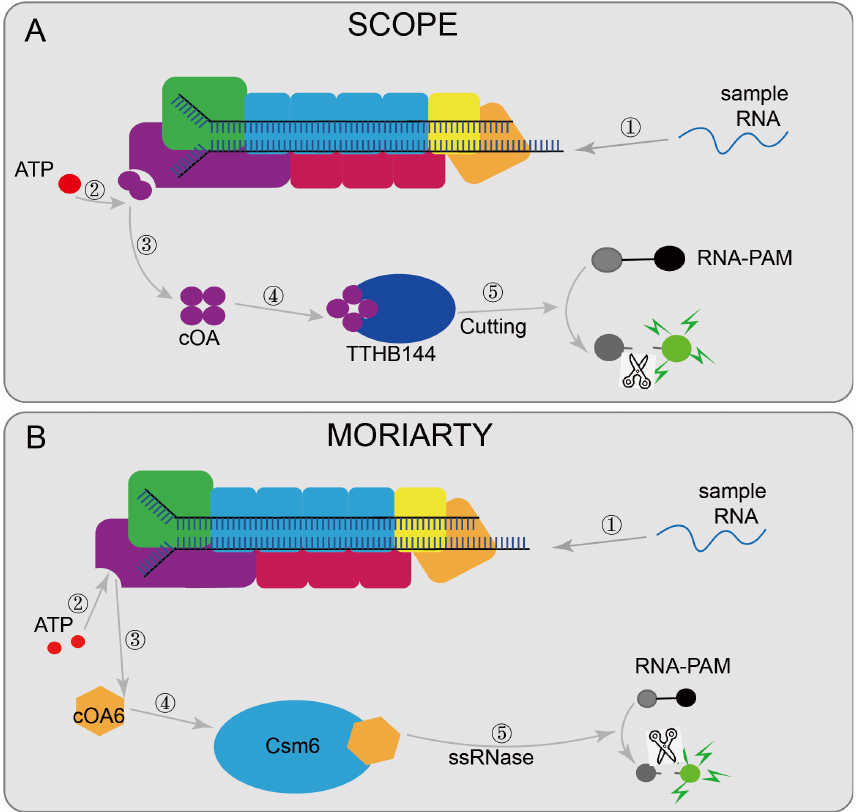
Figure 7. Applications of CRISPR/Cas10 technology: ( A ) MORIARTY, when the target sequence is present, activates Csm1 and synthesizes cOA6 with the participation of divalent ions and ATP, and then cOA6 activates the RNase activity of Csm6, lastly cleaving RNA-FAM; ( B ) SCOPE designed a TtCmr/crRNA complex targeting RNA; after the complex recognizes the target RNA, it can produce cOA molecules, which in turn triggers the cleavage of the reporter RNA by TTHB144, thereby generating a detectable fluorescent signal for result reading.